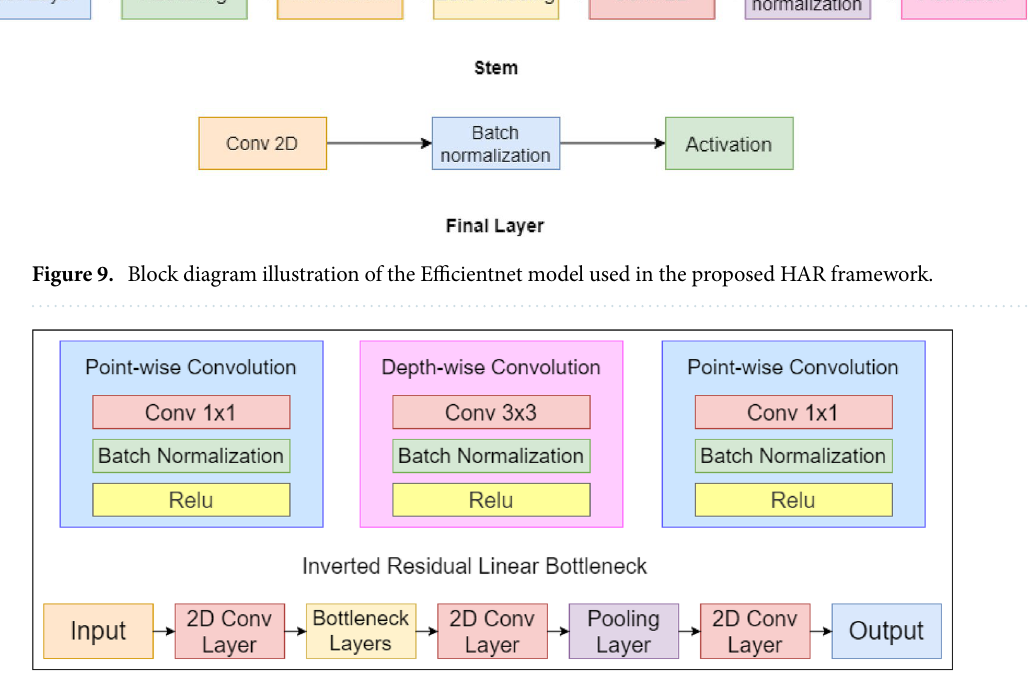
Figure 10. Architectural representation of the Mobilenet_v3 CNN model employed in the proposed